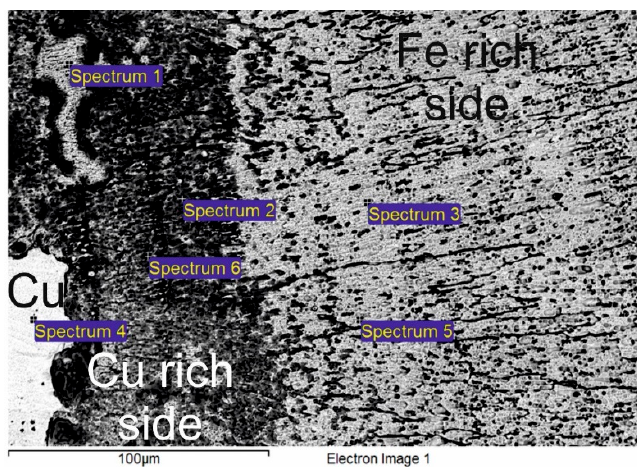
Figure 7. Locations of measurement of local chemical composition by means of EDS analysis (weld No. 5).